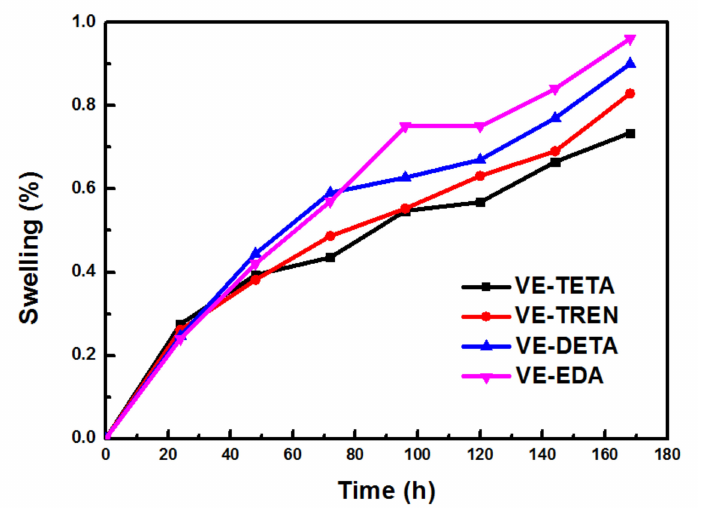
Figure 6. Swelling behaviors of the different vanillyl alcohol–based bioepoxy resin